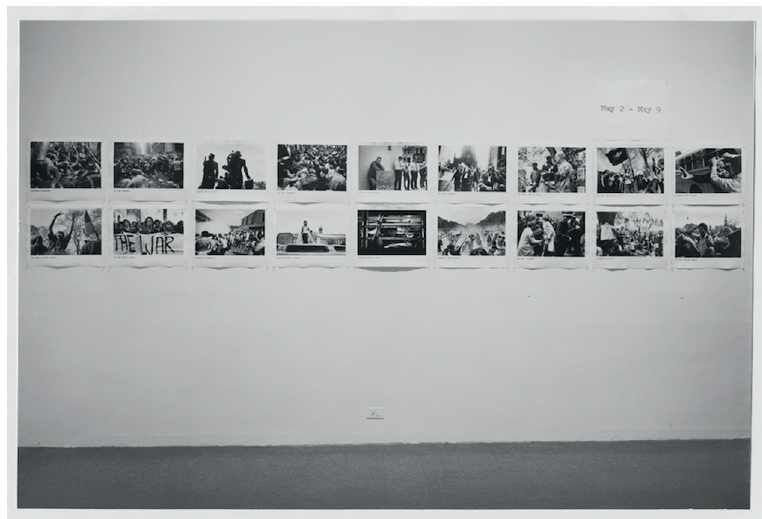
Figure 8. Installation view of Protest Photographs , Museum of Modern Art, New York, May 23 to June 2, 1970. Gelatin silver print, 15.9 cm × 24.1 cm. Photographer: James Mathews. © The Museum of